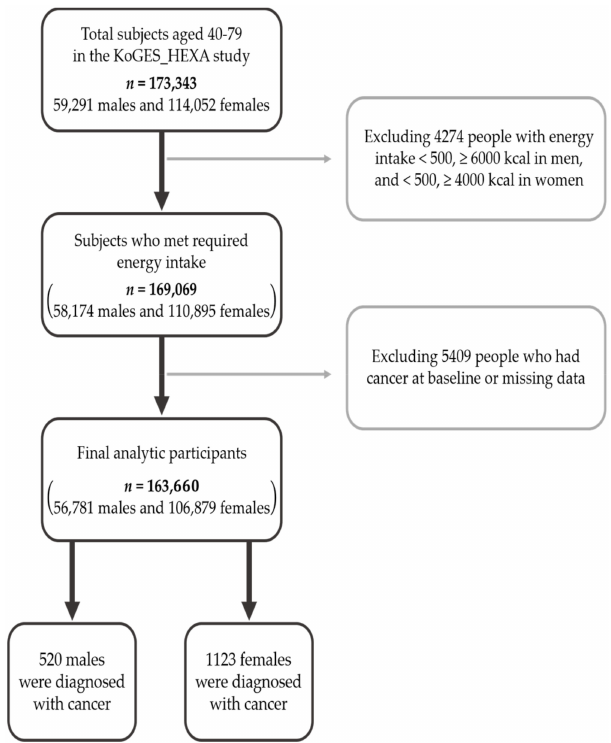
Figure 1. Flow chart of analytical samples in KoGES_HEXA